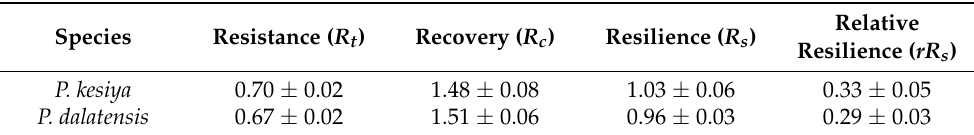
Table 2. Sensitivity indicators ( R t —resistance, R c —recovery, R s —resilience and rR s —relative re- silience) of P. kesiya ( n = 32) and P. dalatensis ( n = 103).